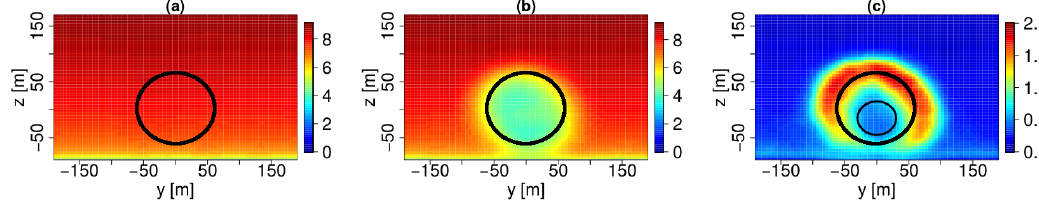
Figure 1. Statistics of the stream-wise velocity u ( y , z , t ) : ( a ) Mean field ( ms − 1 ) far upstream of the turbine; ( b ) Mean field ( ms − 1 ) , 3.5 D away from the turbine; ( c ) Variance ( m 2 s − 2 ) 3.5 D away from the turbine. The large black circle marks the rotor area of a turbine in the wake flow, which is modeled later using aeroelastic simulations. The small black circle marks the central region of the wake, which is used to build a spectral surrogate in Section 6.